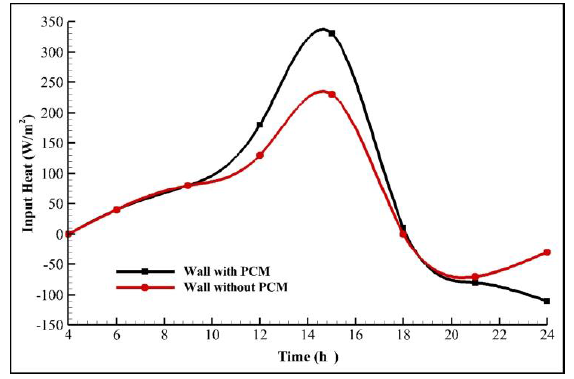
Figure 12. Heat flux through the internal surface of the non ‐ PCM ‐ and PCM ‐ treated south walls.